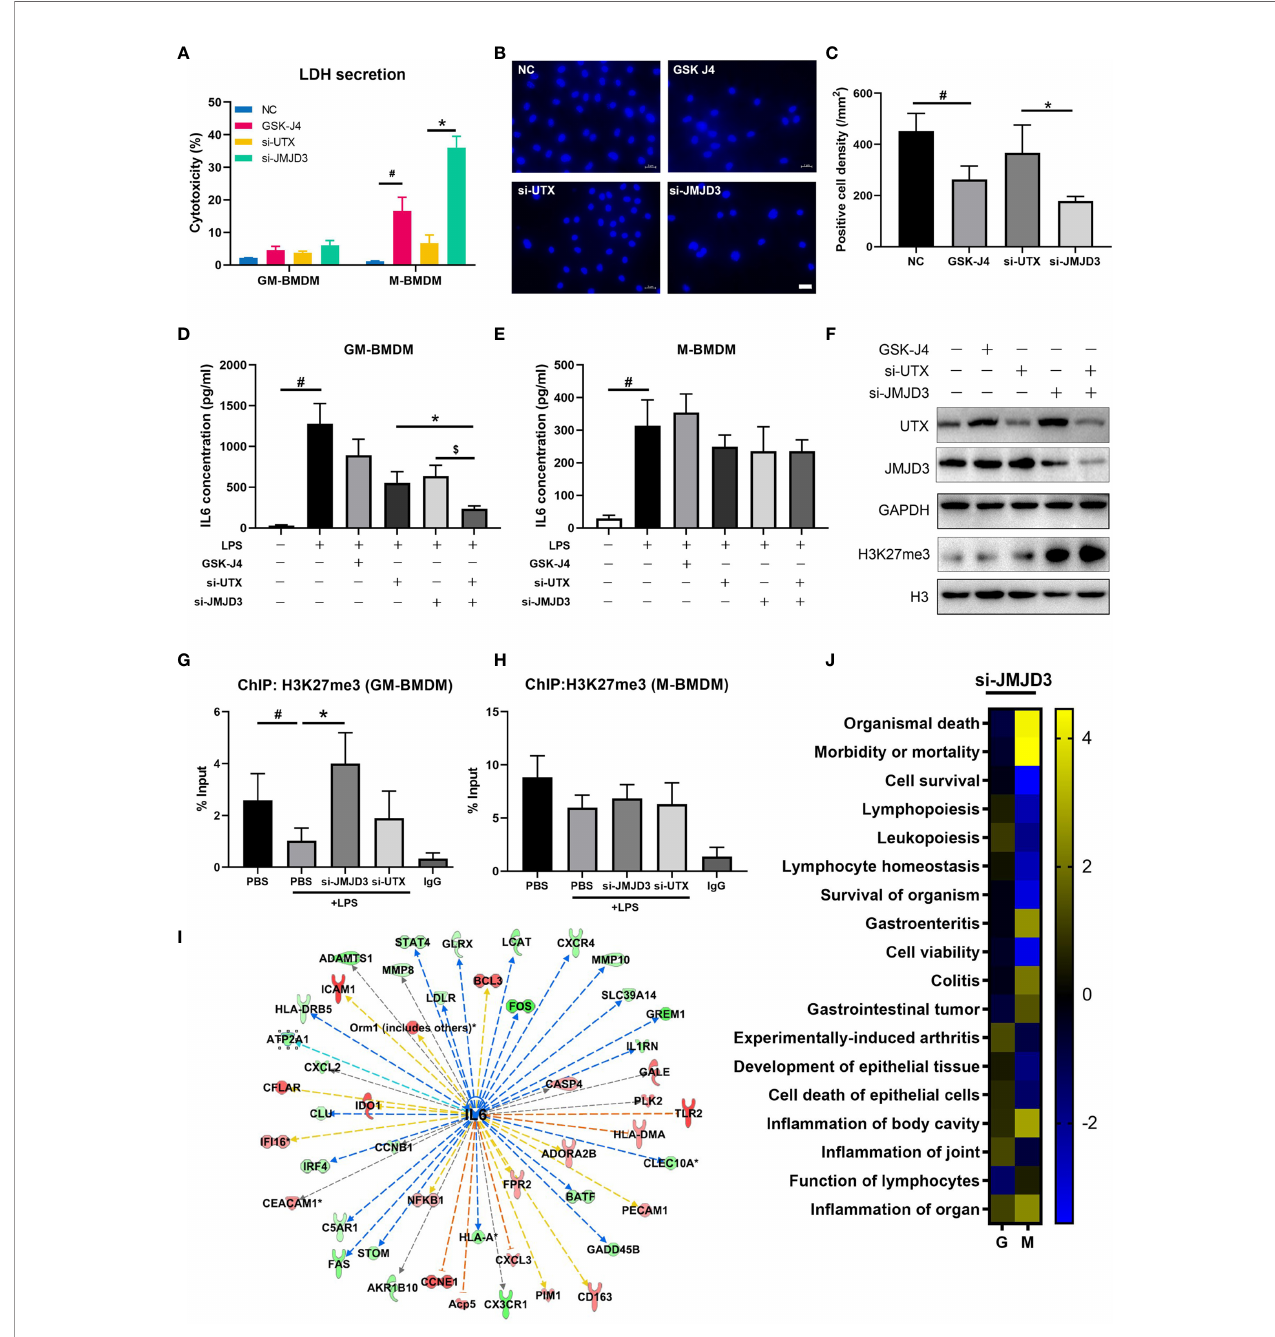
FIGURE 6 | JMJD3 regulates macrophage survival and is the major contributor to H3K27me3 mediated IL6 transcription. (A) GM-BMDMs and M-BMDMs were left untreated (NC), or treated with GSK-J4 for 48 hours, or transfected with UTX siRNAs (si-UTX) or JMJD3 siRNAs (si-JMJD3) for 48 hours. The culture media were collected and the LDH concentration in the media were determined. (B) Representative images from M-BMDMs prepared as in (A) and stained with DAPI, white scale bar represents 50 m m. (C) Quanti fi cation of slides prepared as in (B) (5 slides/treatment group). (D, E) GM-BMDMs and M-BMDMs were treated as in (A) , and the IL6 concentrations in the media were detected by ELISA. (F) GM-BMDMs were treated as in (A) , and cell lysates were used to detect the protein levels of UTX, JMJD3 and H3K27me3. (G, H) GM-BMDMs or M-BMDMs were treated with PBS for 48 hours (PBS), or PBS 48 hours followed by LPS 1 hour (PBS+LPS), or transfected with UTX siRNAs (si-UTX) or JMJD3 siRNAs (si-JMJD3) for 48 hours. The cell nuclei lysates were used for H3K27me3 ChIP assays. After de-crosslinking, the H3K27me3 binding DNA fragment were examined for IL6 promoter (-952 to -1008) enrichment. (I) IPA analyzed RNA-seq data of si-JMJD3 transfected GM- BMDMs, and summarized the top upstream regulator, the detailed information of IL6 was shown. (J) IPA analyzed the activation scores of different signaling pathways in LPS (100 ng/ml for 1 hour) stimulated, si-JMJD3 transfected GM-BMDMs or M-BMDMs. Error bars indicate SD, p < 0.05 (two-tailed Student ’ s T-test) is indicated by * for comparison with si-UTX vs. si-JMJD3, # for comparison with NC vs. LPS, $ for comparison with si-JMJD3 vs. si-JMJD3 and